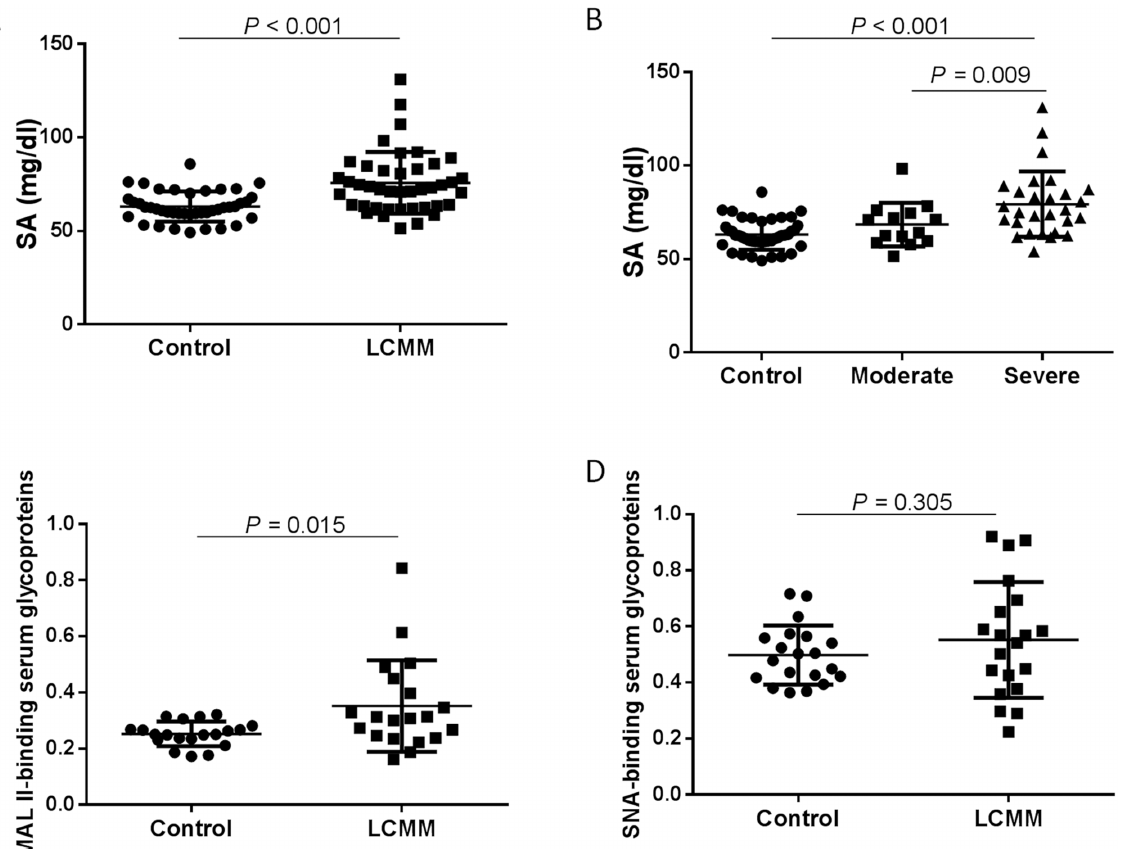
Fig 5. The levels of serum salic acid (SA) and sialylated glycoproteins. The increased levels of serum salic acid (SA) and sialylated glycoproteins in LCMM patients were clarified by enzymatic method and using lectin blot, respectively. (A): The horizontal axis represents the experimental groups: control (n = 42), LCMM (n = 42). The vertical axis indicates the serum SA level (mg/dl), and error bars are mean ± standard deviations. (B) and (C): Lectin blots of serum glycoproteins were probed with MAL II and SNA representing the α -2,3-linked and α -2,6-linked sialylated proteins. The horizontal axis represents the experimental groups: control (n = 20) and LCMM (n = 20). The vertical axis indicates the fluorescence intensity ratio of MAL II or SNA binding proteins to total proteins stained by coomassie blue (CBB), and error bars are mean ± standard deviations. MAL II binding α -2,3-linked sialylated protein increased in LCMM patients, whereas there was no significant change in SNA binding α -2,6-linked sialylated proteins between LCMM patients and